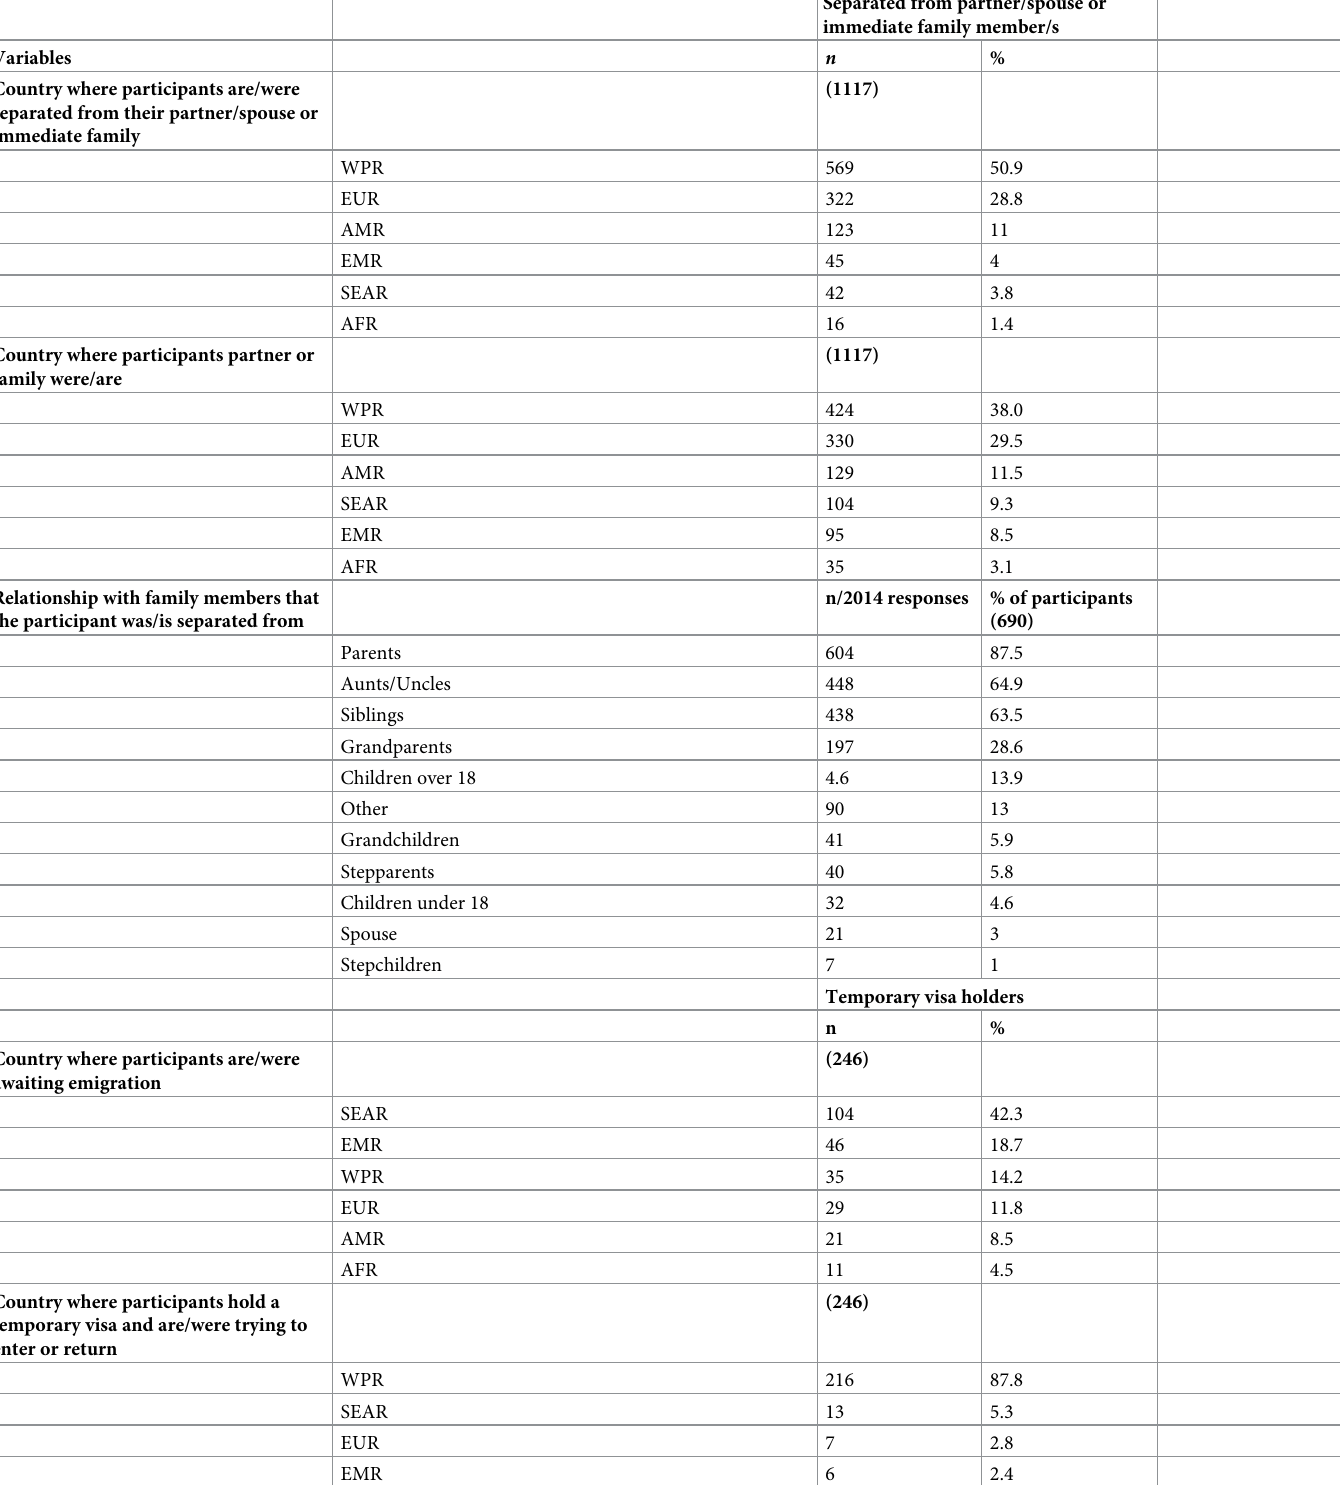
Separated from partner/spouse or immediate family member/s